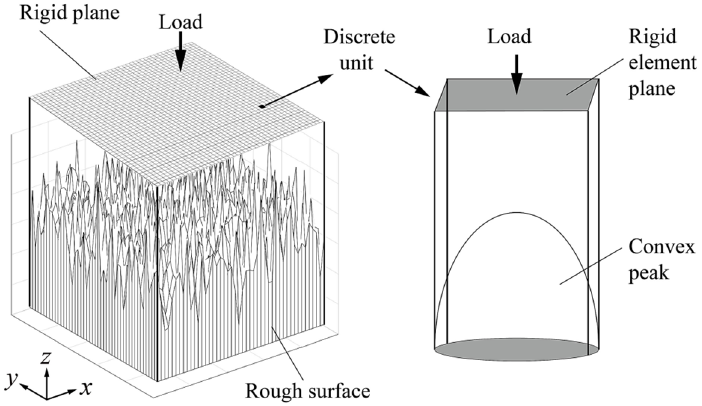
Figure 5. Rough surface discretization characterization.